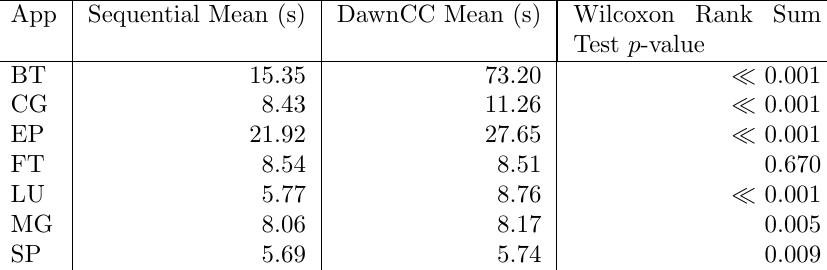
Table 5: DawnCC’s performance on the SNU-NPB suite’s sequential implemen-